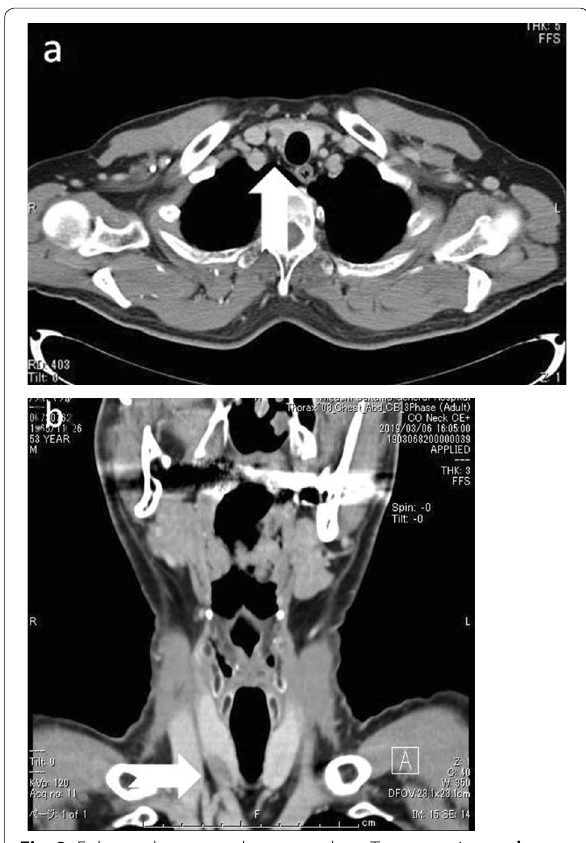
Fig. 2 Enhanced computed tomography. a Transverse image. b Sagittal image. Images obtained by CT revealed a low density mass which was slightly enhanced by contrast injection in the right thyroid lobe